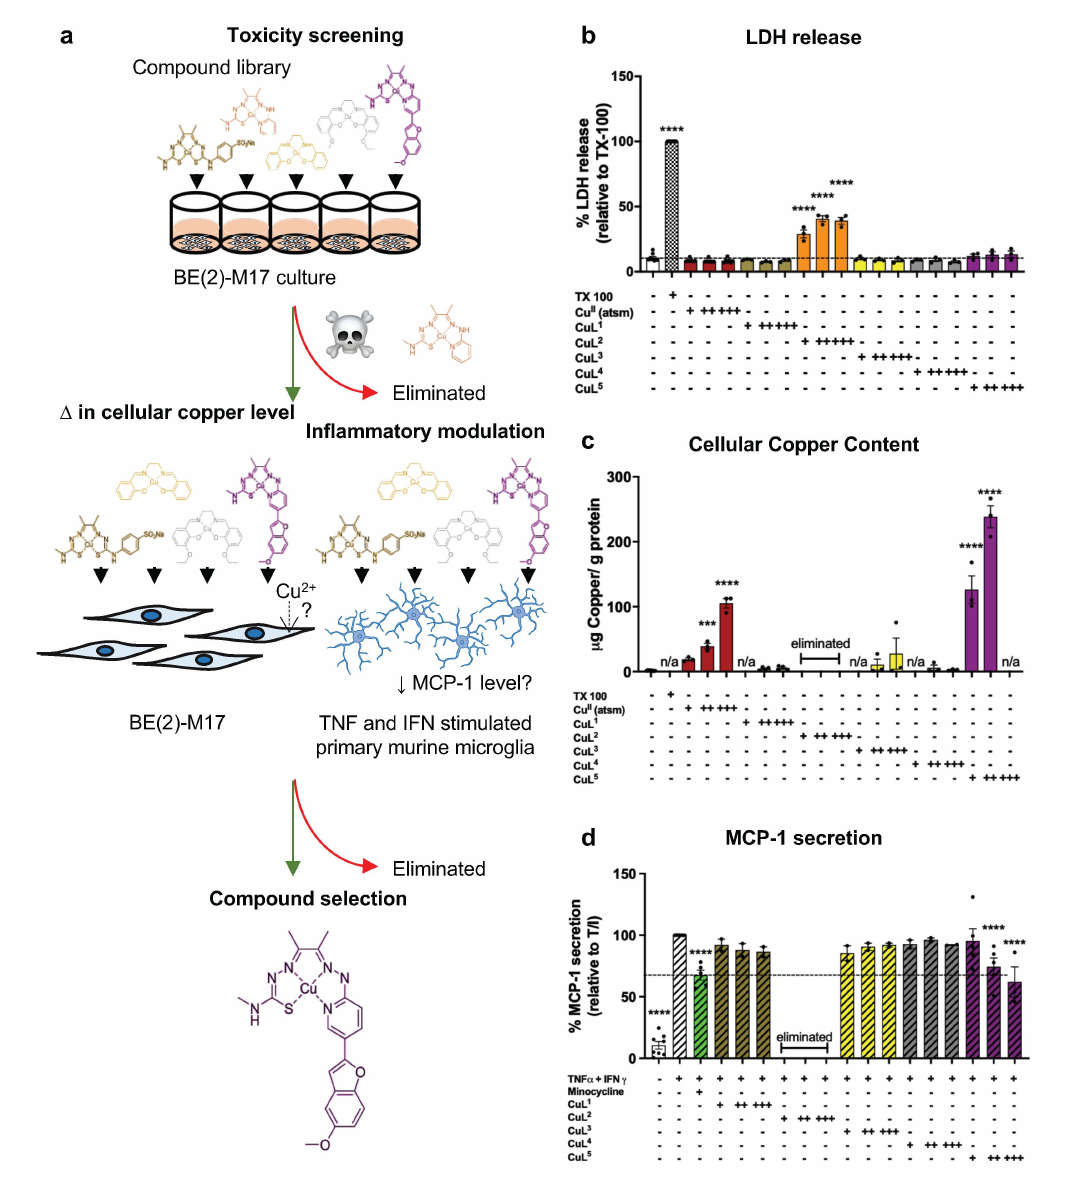
Figure 2. CuL 5 treatment exhibited inflammation-modulating effect. ( a ) Workflow of the screening pipeline to identify leading compound(s). ( b , c ) M17 cultures were incubated for 24 h with new- generation metal compounds (2–10 µ M). ( b ) Cell viability and ( c ) cell–copper association were determined by LDH assay and ICP–MS, respectively. ( d ) Primary murine microglial cultures were stimulated with TNF α (10 ng/mL) and IFN γ (15 ng/mL) and concurrently treated with 20 µ M minocycline or varying concentrations of CuL 1 , CuL 2, CuL 3 , CuL 4 , or CuL 5 for 24 h. MCP-1 secretion by microglia was measured by ELISA. Data are expressed as ( b ) percentage LDH released relative to Triton X-100 (TX 100)-treated positive control, ( c ) µ g copper per g cellular protein, and ( d ) percentage of MCP-1 released relative to TNF α - and IFN γ -stimulated positive control and presented as the mean ± S.E.M. Dotted line represents ( b ) average % LDH release of the media-only negative control and ( d ) average % MCP-1 released when TNF α - and IFN γ -stimulated microglia were treated with minocycline. Determined by one-way ANOVA, compared to ( b , c ) media-only or ( d ) TNF α - and IFN γ -stimulated controls ***/**** = p ≤ 0.001/0.0001. Numbers on x -axes represent µ M compound. n/a = concentration not